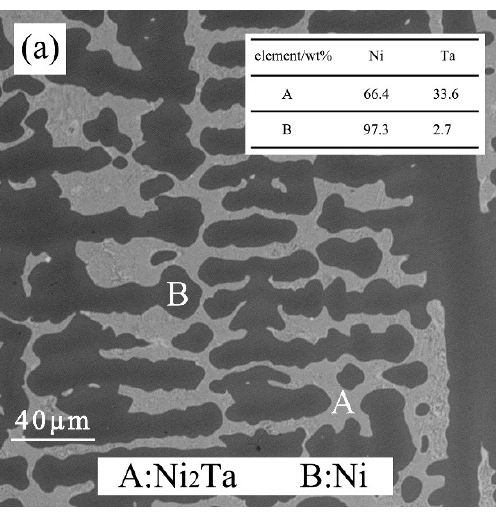
Figure 2. SEM images of the Ni ‐ based alloys: ( a ) Ni ‐ 3Ta, ( b ) Ni ‐ 3Y.